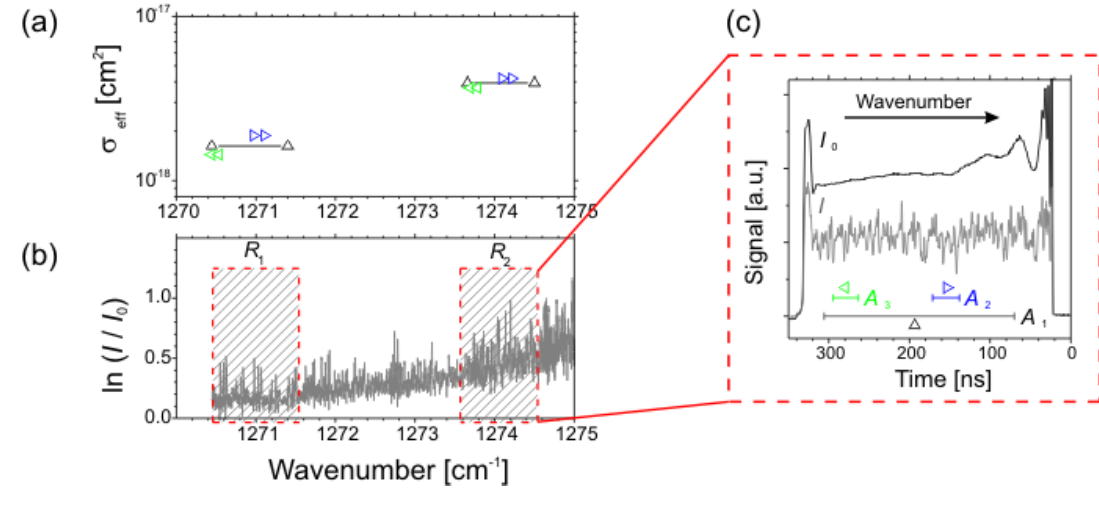
Figure 5. (a) Example of retrieving effective absorption cross sections from two different spectral ranges within the ν band of CF . (b) Tuning the QCL heat sink temperature 3 4 stepwise yielded a total spectral sweep of about 6 cm -1 . (c) Single baseline ( I ) and 0 transmission spectra ( I ) of CF (0.1 mbar, 90 cm absorption path) obtained by applying 4 long QCL pulses of 300 ns. Effective absorption cross sections σ were measured in two eff and R ). Calibration results from 3 different spectral micro-windows spectral ranges ( R 1 2 ( A —triangle up, A —triangle right, and A —triangle left) within a specific range R were in 1 2 3 good agreement (a) (adapted from